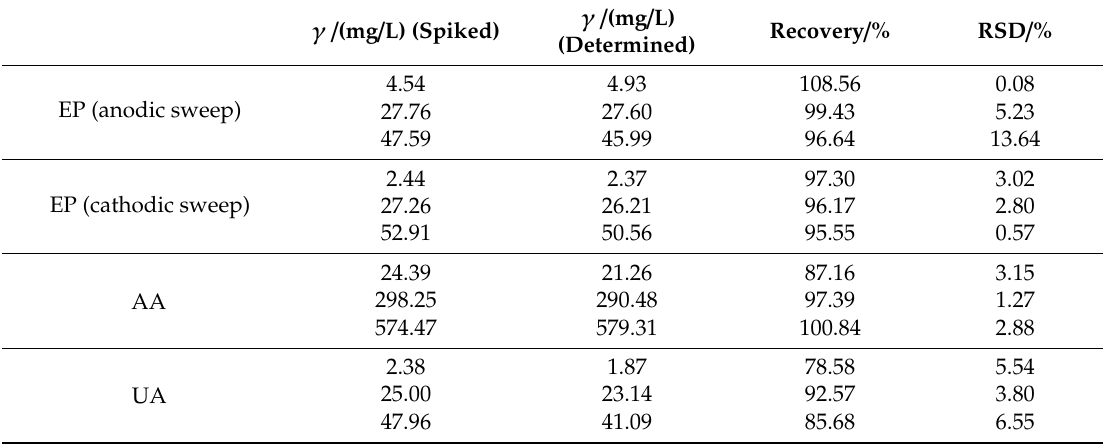
Table 5. Average recoveries and RSD values using the weighted regression model.